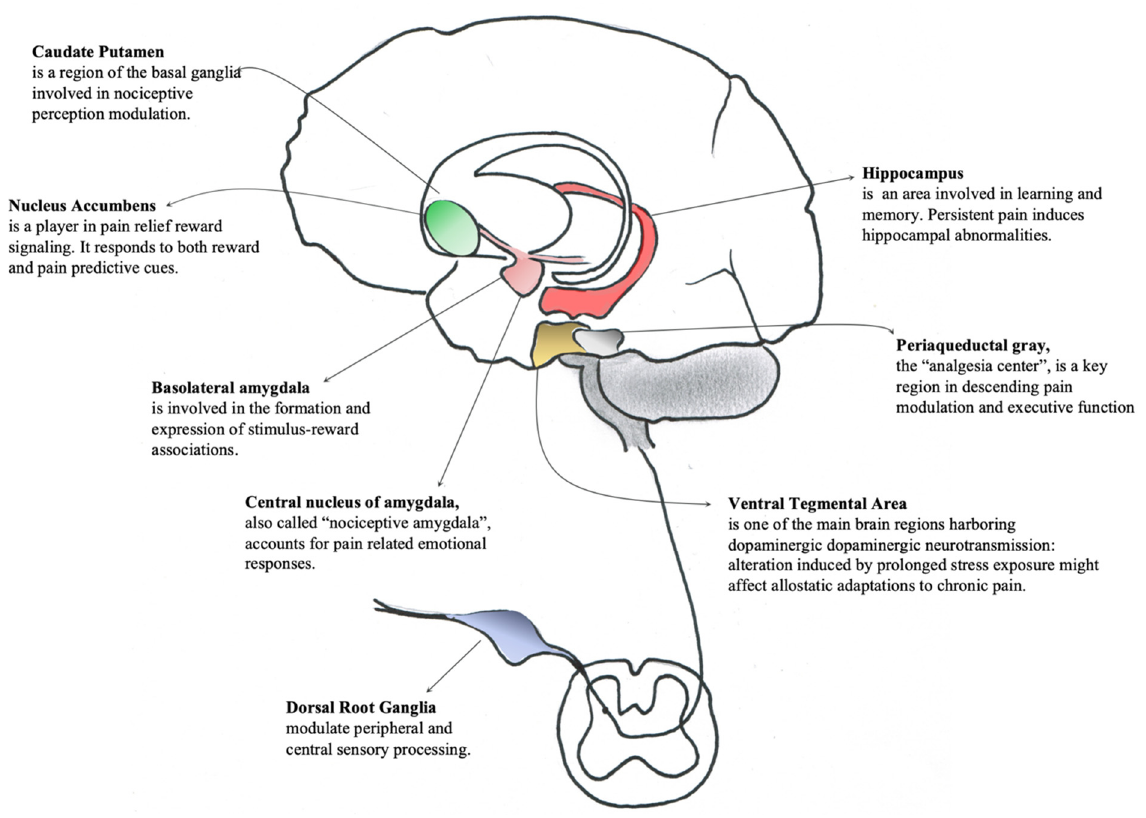
Figure 2. Evidenced areas involved in prescription opioids action and their role in pain